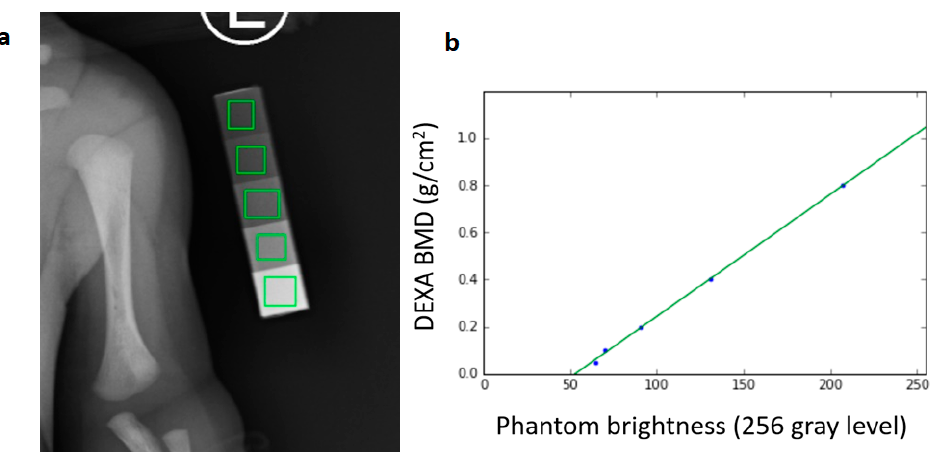
Figure 4. ( a ) A five-step phantom in the radiograph. Five green squares are manually selected to measure the average brightness of each step region. ( b ) The relationship between phantom brightness and corresponding dual-energy X-ray absorptiometry bone mineral density (DEXA BMD).